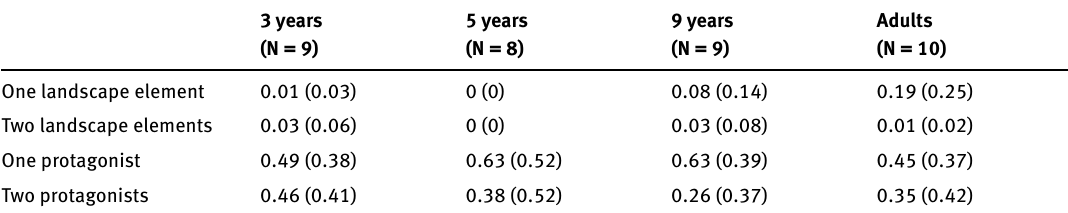
Table 3. The mean proportion and standard deviations (in parentheses) of referents of gestures with a two-handed